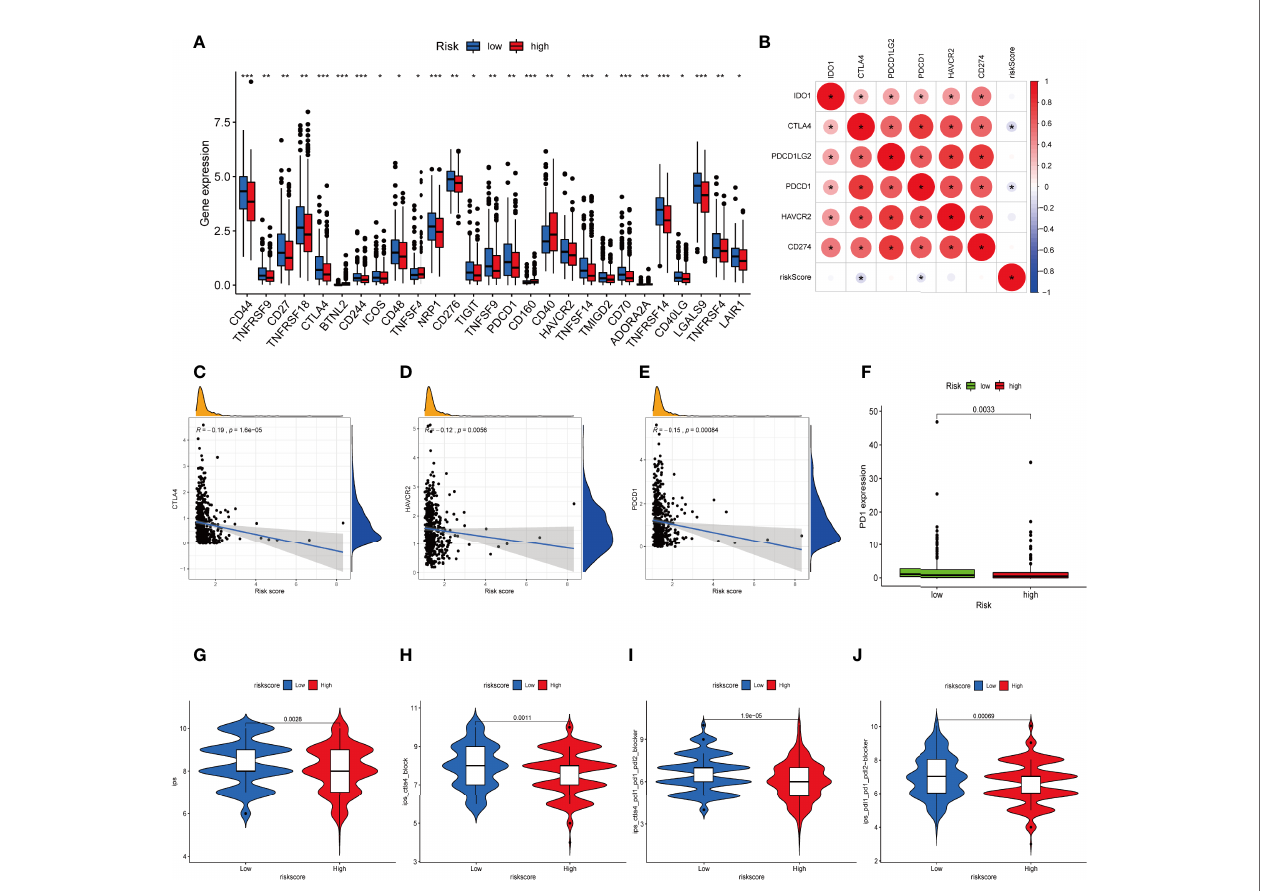
FIGURE 9 | Difference in ICGs expression in the two IRLPS groups. (A) The boxplot shows the correlation of ICGs and risk score. (B) Correlation between expression of ICGs and IRLPS. (C-E) Correlation analysis reveals expression levels of ICGs (C) CTLA-4, (D) HAVCR-2, and (E) PDCD1 are negatively related to IRLPS risk score. (F) Boxplot illustrates signi fi cantly higher expression of ICG PD-1 in the IRLPS low-risk group than in the high-risk group. (G – J) IPS scoring reveals (G) IPS, (H) IPS-CTLA4, (I) IPS-CTLA-4/PD-L1/PD-1/PD-L2, and (J) IPS-PD-L1/PD-1/PD-L2 scores were all signi fi cantly higher in the low-risk group. *P < 0.05; **P < 0.01; ***P <